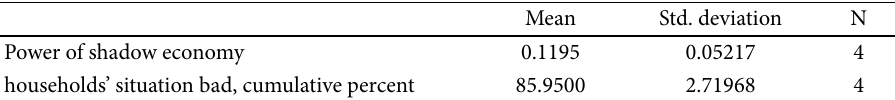
Table 5. Descriptive statistics of the distribution of households in Lithuania in accordance with a house- hold’s ability to make ends meet and the variables of shadow economy power, 2008–2011